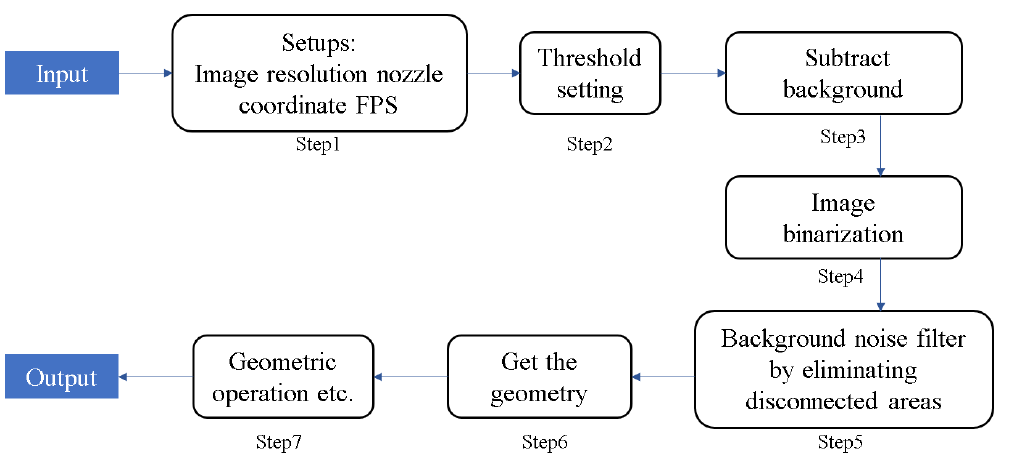
Figure 7. Image processing of MATLAB ® .